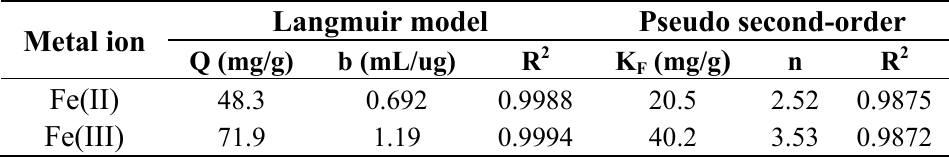
Table 2. Parameters of Langmuir and Freundlich models for Fe(II) and Fe(III) adsorption.